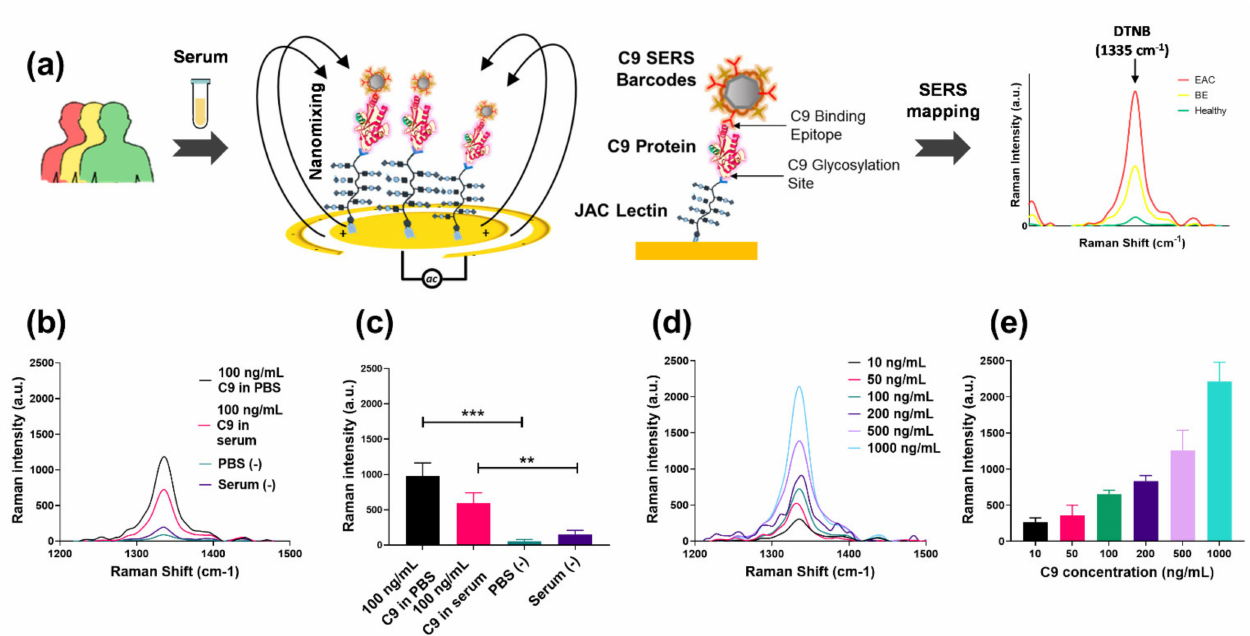
Figure 3. Establishing the EndoScreen Chip. ( a ) Schematic workflow of the chip assay for JAC-C9 detection. JAC-mediated glycoprotein isolation from denatured serum samples and C9 labelling by SERS barcode-tagged anti-C9 antibody is performed under the stimulation of a nanoscopic fluid flow. JAC-C9 is detected by SERS mapping, where the Raman reporter DTNB that is conjugated to the SERS barcodes provides a characteristic Raman peak at 1335 cm − 1 . ( b ) Raman spectra of 100 ng/mL C9 in PBS (black), 100 ng/mL C9 in diluted serum (pink), blank PBS (cyan) and diluted serum (purple). ( c ) Corresponding averaged Raman signal intensity of DTNB (1335 cm − 1 ). ( d ) Raman spectra and ( e ) averaged Raman signal intensity of DTNB (1335 cm − 1 ) obtained for designated C9 concentrations spiked in diluted serum. The error bars are the standard error of three replicates. ** p < 0.01 and *** p <